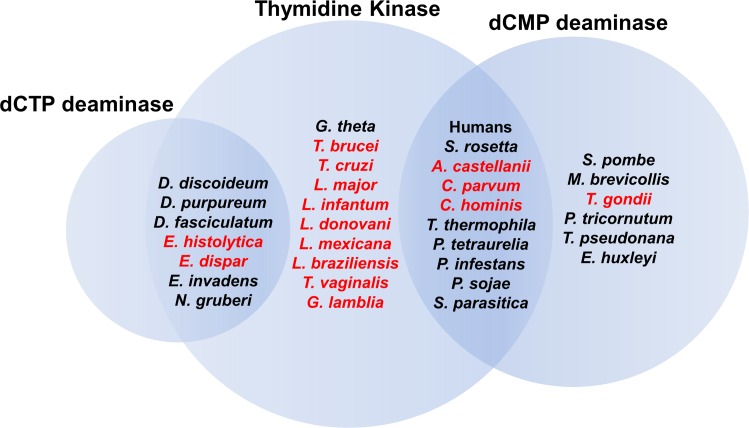
Venn diagram showing the distribution of TK, DCTD and dCTP deaminase in representative protists and higher eukaryotes.The overlapping regions represent organisms that possess both of the indicated genes.